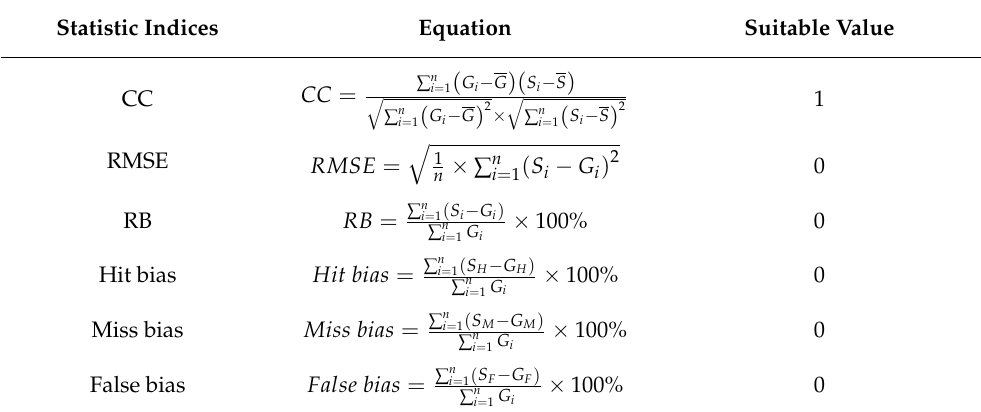
Table 1. The list of the evaluation metrics 1